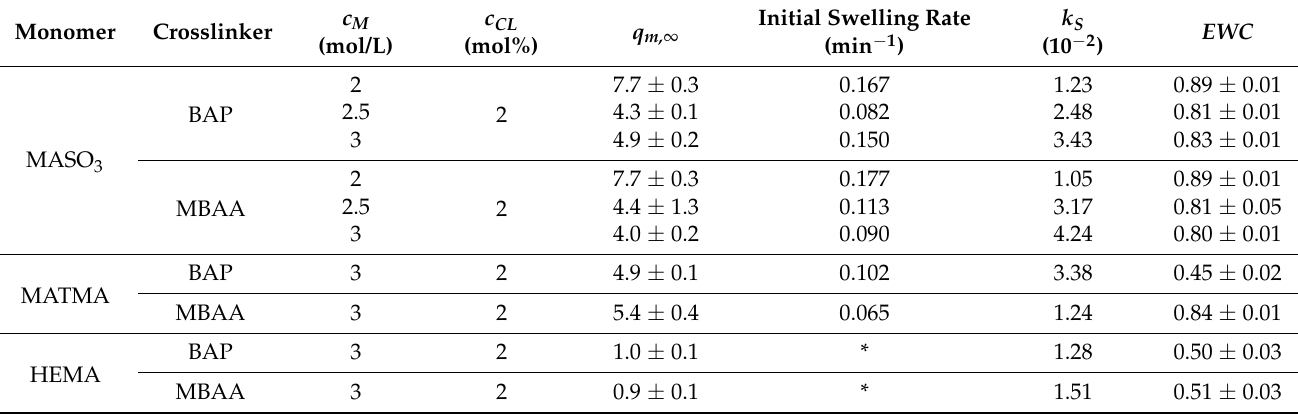
Table 2. Comparison of the volumetric ( q v, ∞ ) and gravimetric ( q m, ∞ ) swelling degree. Monomer